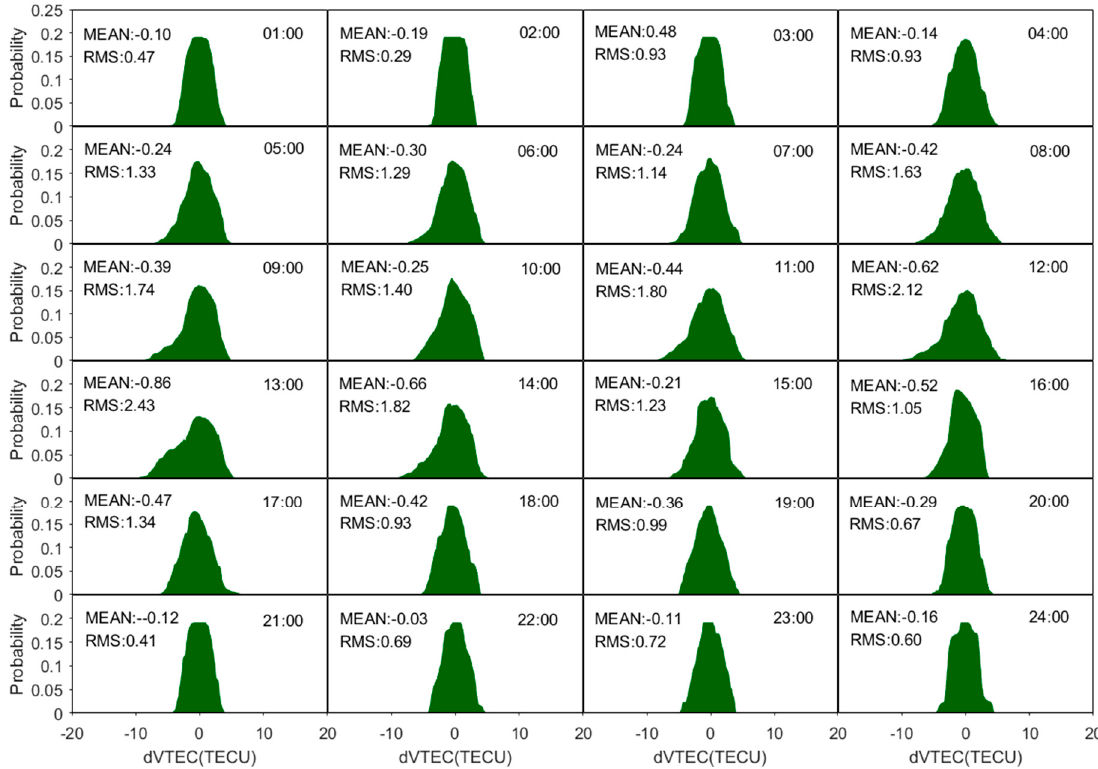
Figure 8. Post-residual distribution of refinement modeling in DOY 78 of RRTGIM-3.